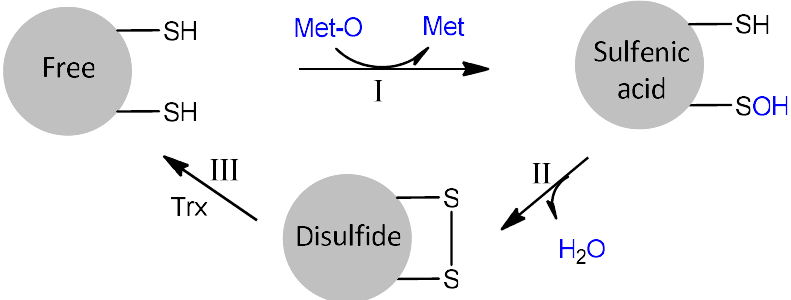
Figure 3. The three-step mechanism of MSRs. In step I, the formation of the MSR/Met-O Michaelis complex allows the nucleophilic attack of catalytic Cys on the sulfur atom of the sulfoxide function of Met-O, leading to the formation of a sulfenic acid intermediate with concomitant release of Met. In step II, the nucleophilic attack of the regenerating Cys on the sulfur atom of the sulfenic acid leads to the formation of a disulfide bond and the release of a water molecule. In step III, the regeneration of the active site in its fully reduced state proceeds via the reduction of the MSR disulfide bond by reduced Trx. For N. meningitidis MSRA and MSRB, the catalytic and regenerating Cys are C51 and C198, and C117 and C63, respectively.